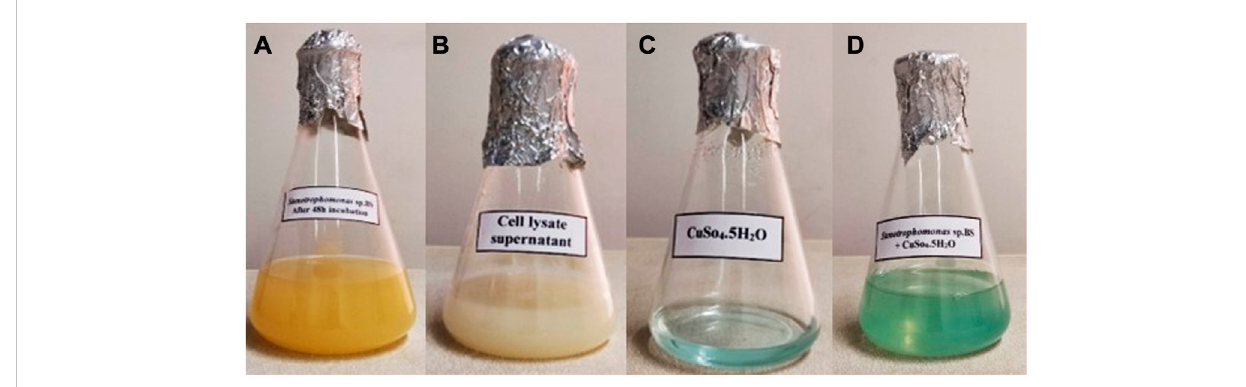
FIGURE 1 Visual detection of biosynthesized CuONPs. Four conical fl asks containing Stenotrophomonas sp. BS95 after 48 h incubation (A) , bacterial CLS (B) , CuSO 4 solution (C) , and biogenic CuONPs (D) .